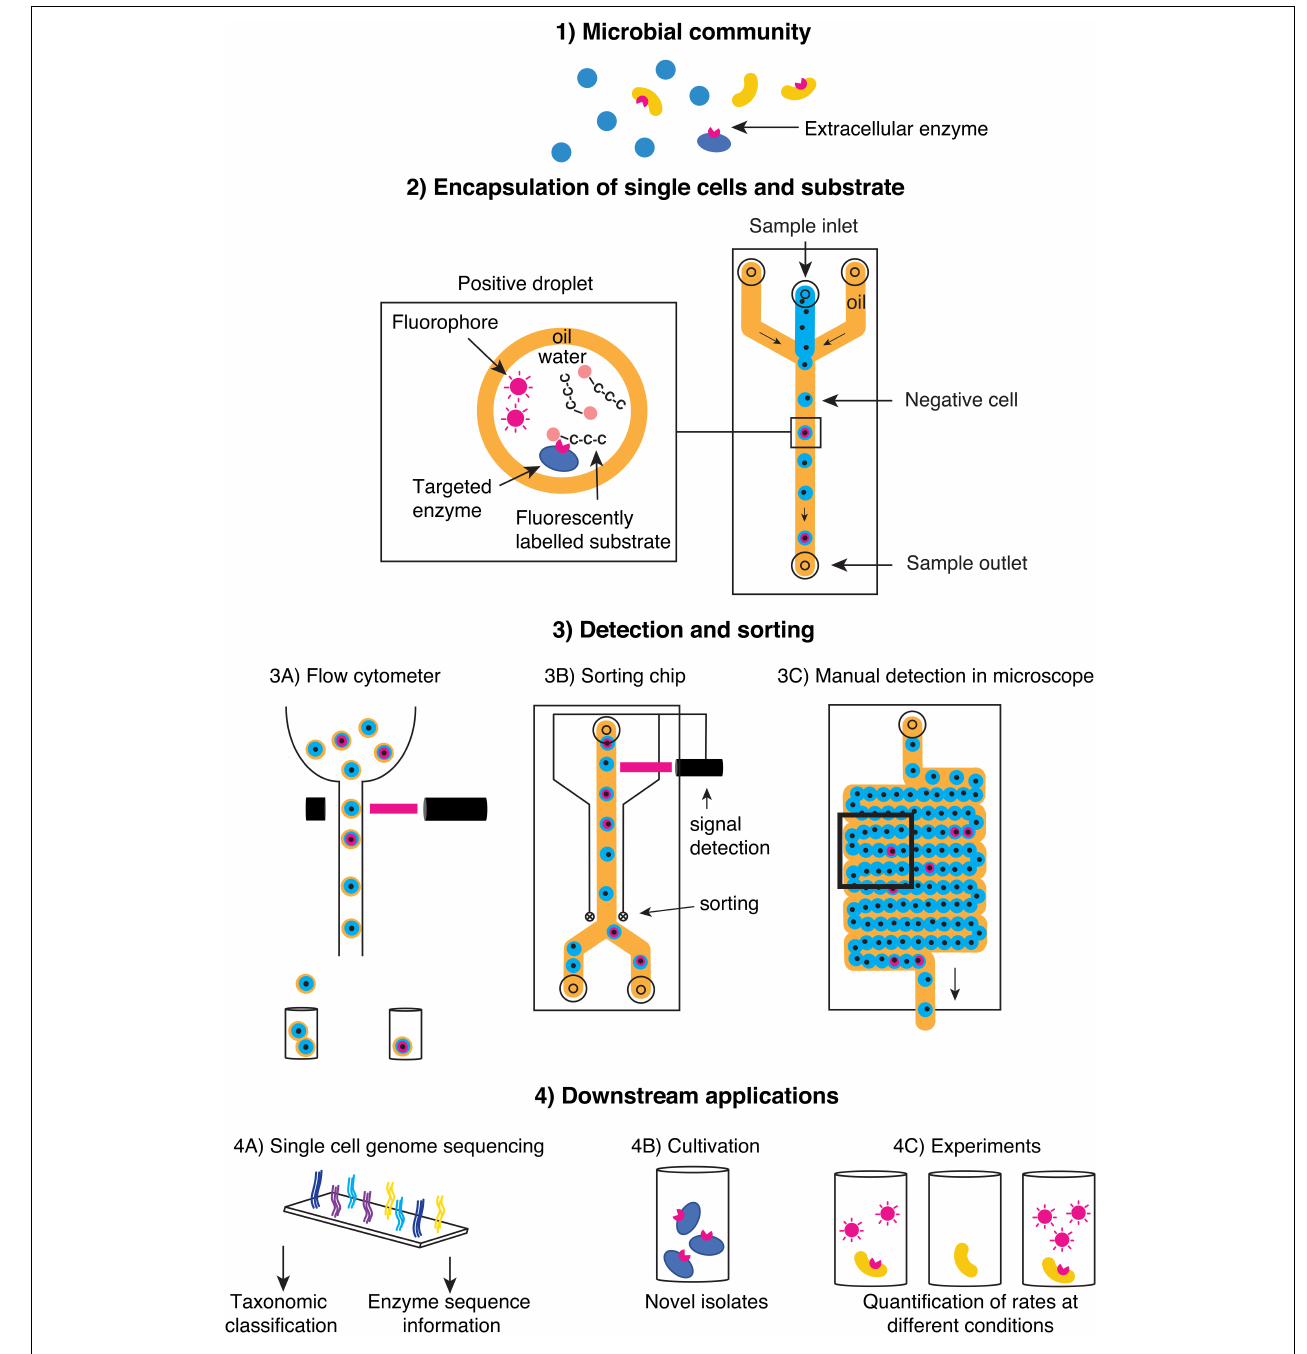
FIGURE 1 | Schematic of a suggested workflow to screen single cells in (1) natural microbial communities using an extracellular enzyme assay in microfluidic droplets. (2) Single cells are encapsulated in droplets together with a labeled substrate, and the presence of extracellular enzyme activity can be detected by the release of fluorophores, which increases fluorescence in the droplet. Depending on the droplet type (oil-water as depicted in 3B,C or water-oil-water in 3A), various screening and sorting platforms can be applied. (4) Microfluidic droplets are biocompatible with a range of downstream applications such as sequencing (4A) or experiments requiring viable cells